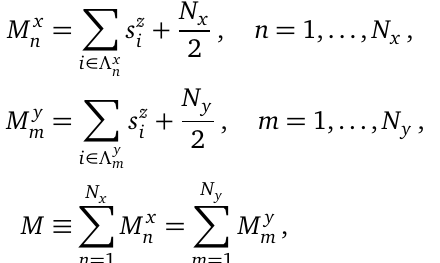
and rows Λ y , m n